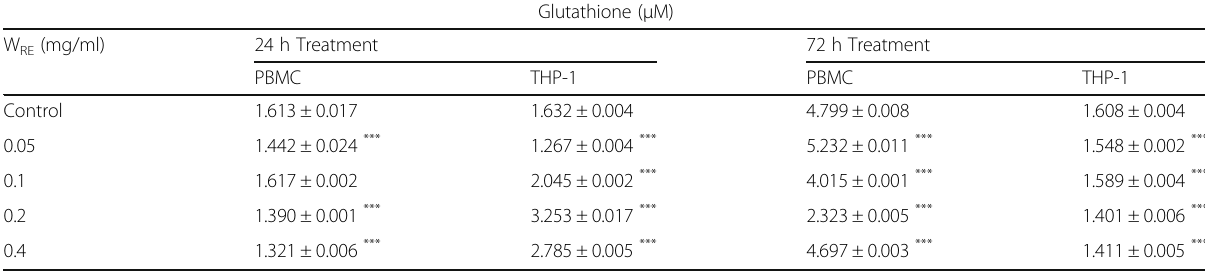
Table 1 Glutathione levels in LPS stimulated and W RE treated PBMC ’ s and THP-1 cells Glutathione ( μ M) W RE (mg/ml) 24 h Treatment 72 h Treatment